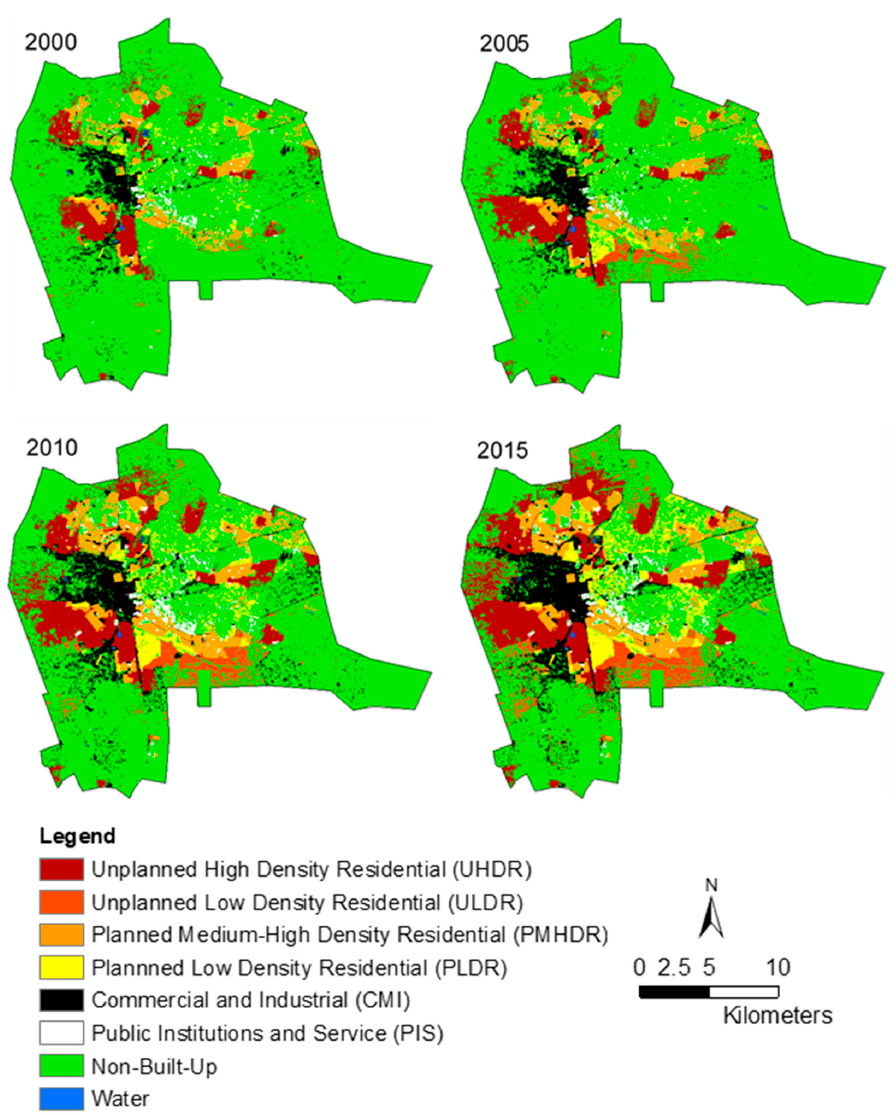
Figure 4. Urban-LU maps for Lusaka city, Zambia, for the years 2000, 2005, 2010, and 2015. Table 3. Intra-urban-LU (ha) expansion statistics for Lusaka city, Zambia, in four time periods between 2000 and 2015.